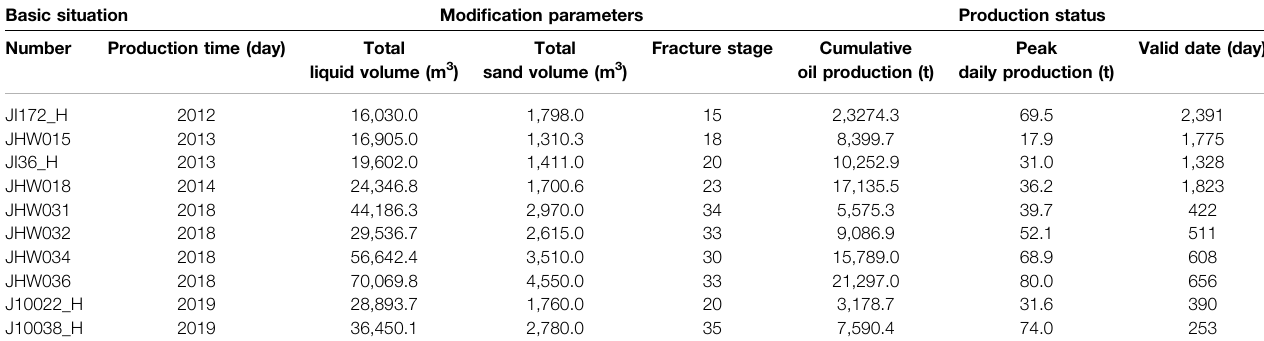
TABLE 4 | Basic information of 10 typical wells in Jimusar.